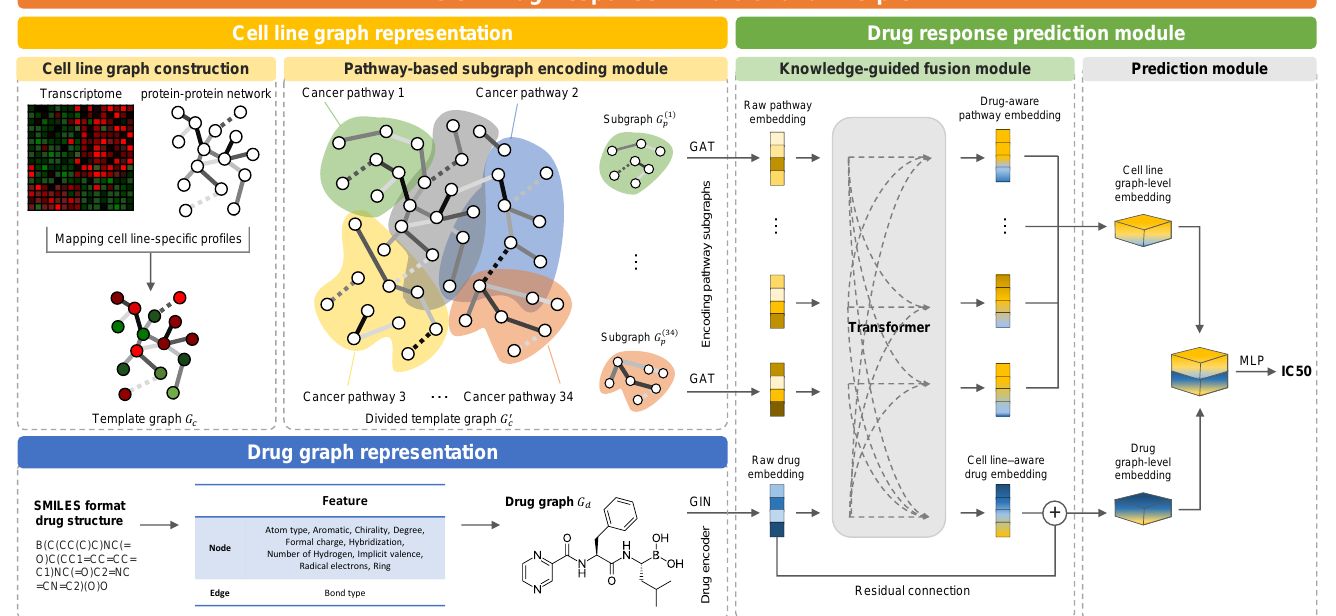
Figure 1. An overview of DRPreter. In the graph representation sections, embeddings of pathway subgraphs and drug molecule were obtained using GNN. With the obtained pathway embeddings and drug embeddings as inputs to the transformer-based cell-line and drug fusion module, the embeddings were updated by reflecting inter-pathway relationships and pathway-drug relationships in the model learning